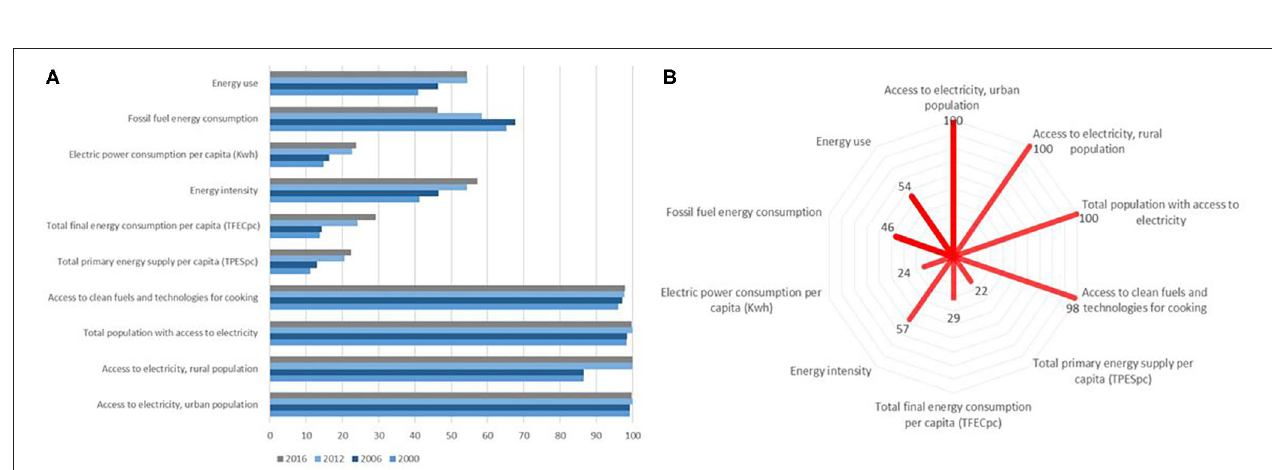
FIGURE 7 | Energy indicators (normalized) — Uruguay (2000, 2006, 2012, 2016).